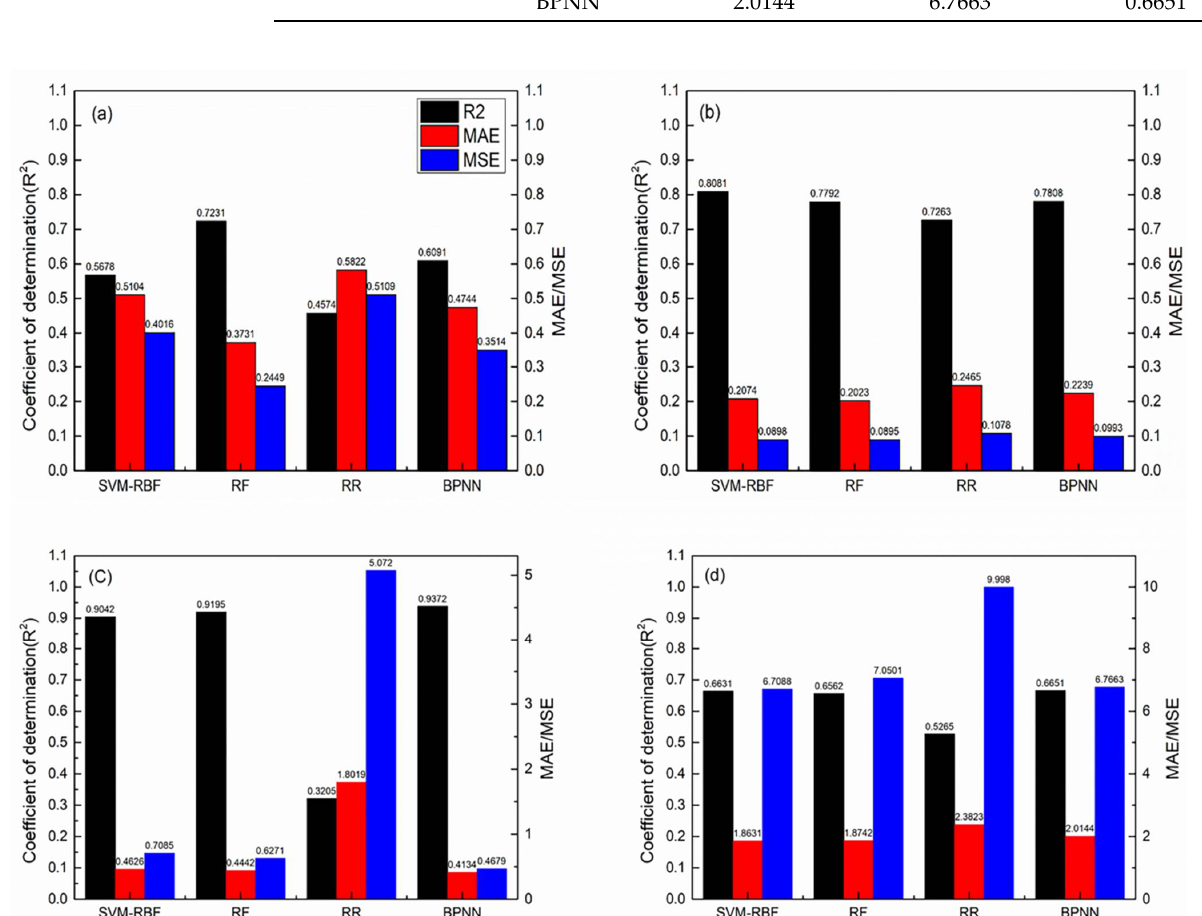
Figure 3. Prediction performance of machine learning model on test set, ( a ) prediction performance of formation energy, ( b ) prediction performance of stability, ( c ) prediction performance of volume, and ( d ) prediction performance of formation energy of oxygen vacancy.